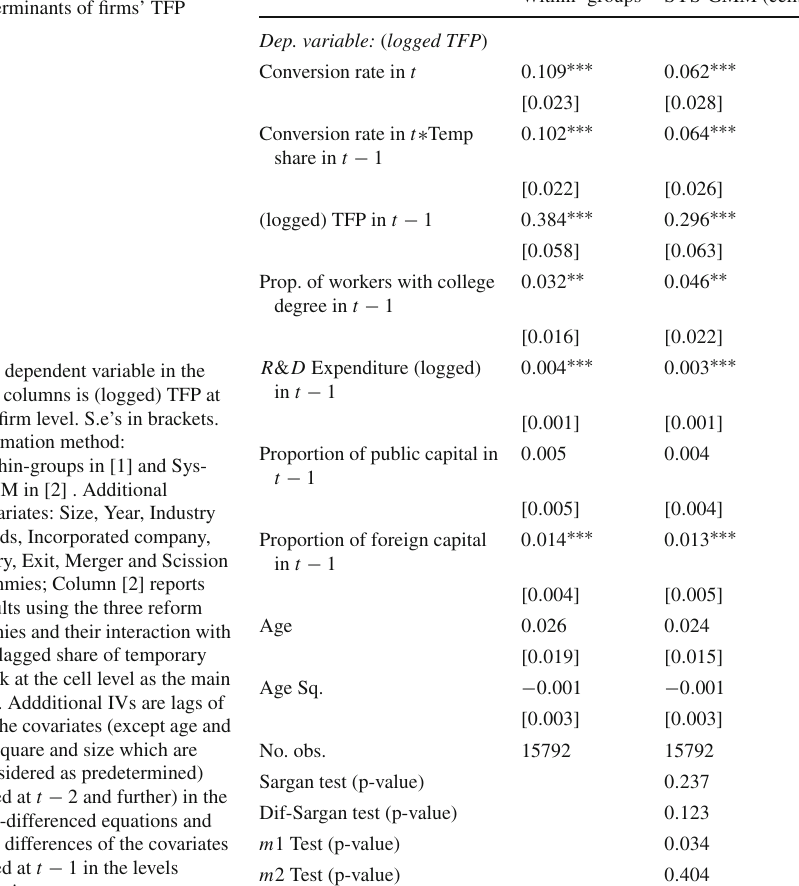
Table 7 Within-groups and Sys-GMM estimates of determinants of firms’